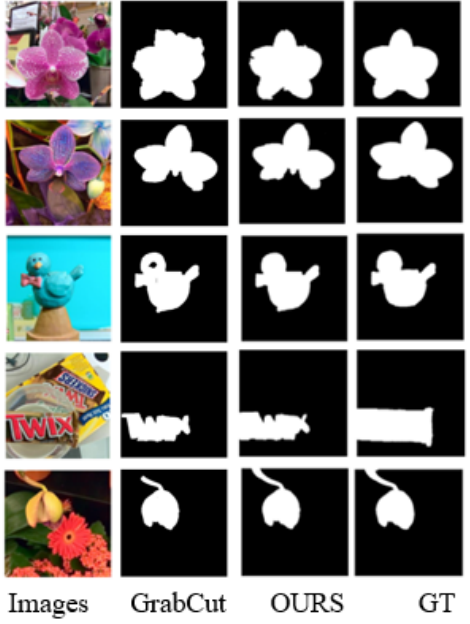
Figure 9. The saliency map obtained by our method and traditional GrabCut.